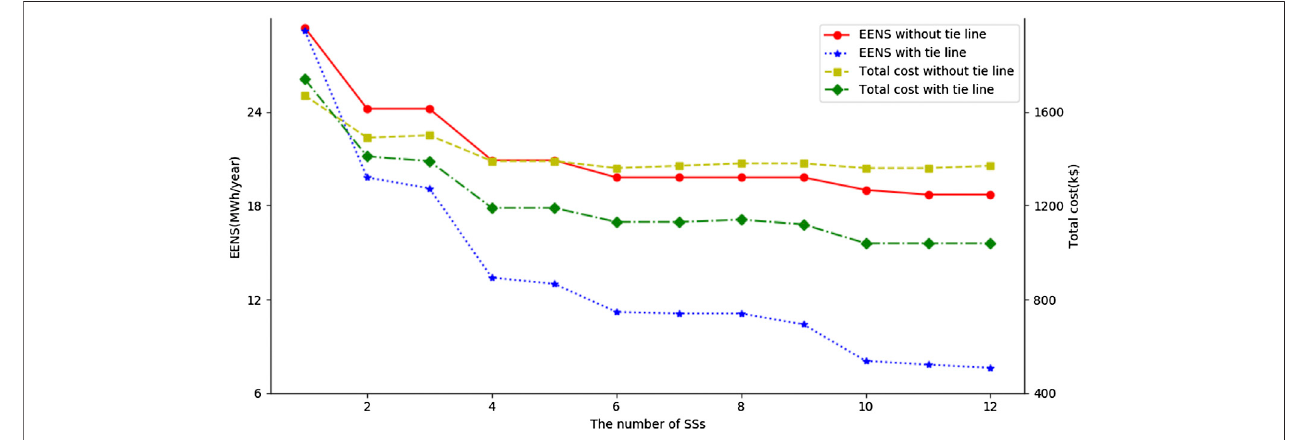
FIGURE 9 | Resultant cost and reliability indexes in the 24 cases.